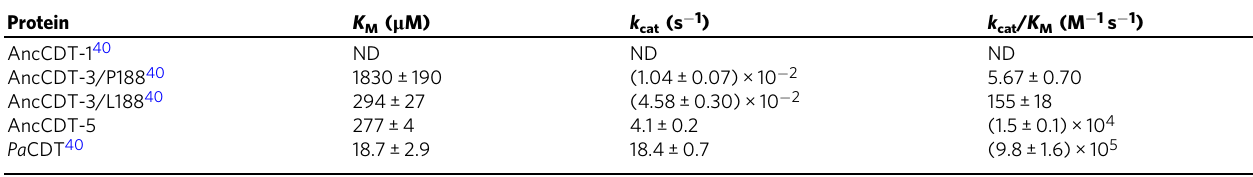
Table 1 Kinetic parameters for prephenate dehydratase activity of CDT variants related to this study a .